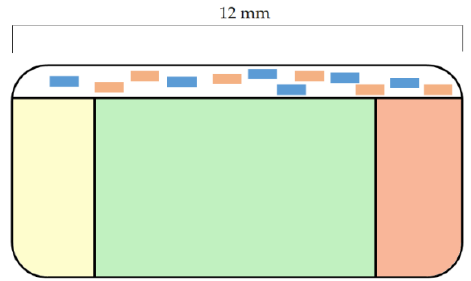
Figure 4. Cross-section of the polypills where ASA and HCT formulations were located in the upper immediate release compartments (labeled with blue and orange rectangles) and atenolol, pravastatin, and ramipril formulations were in three distinct extended release compartments (labeled with yellow, green, and peach blossom). The three compartments were the same size but could be visualized like this because of the original design of the “cake slice” [37].